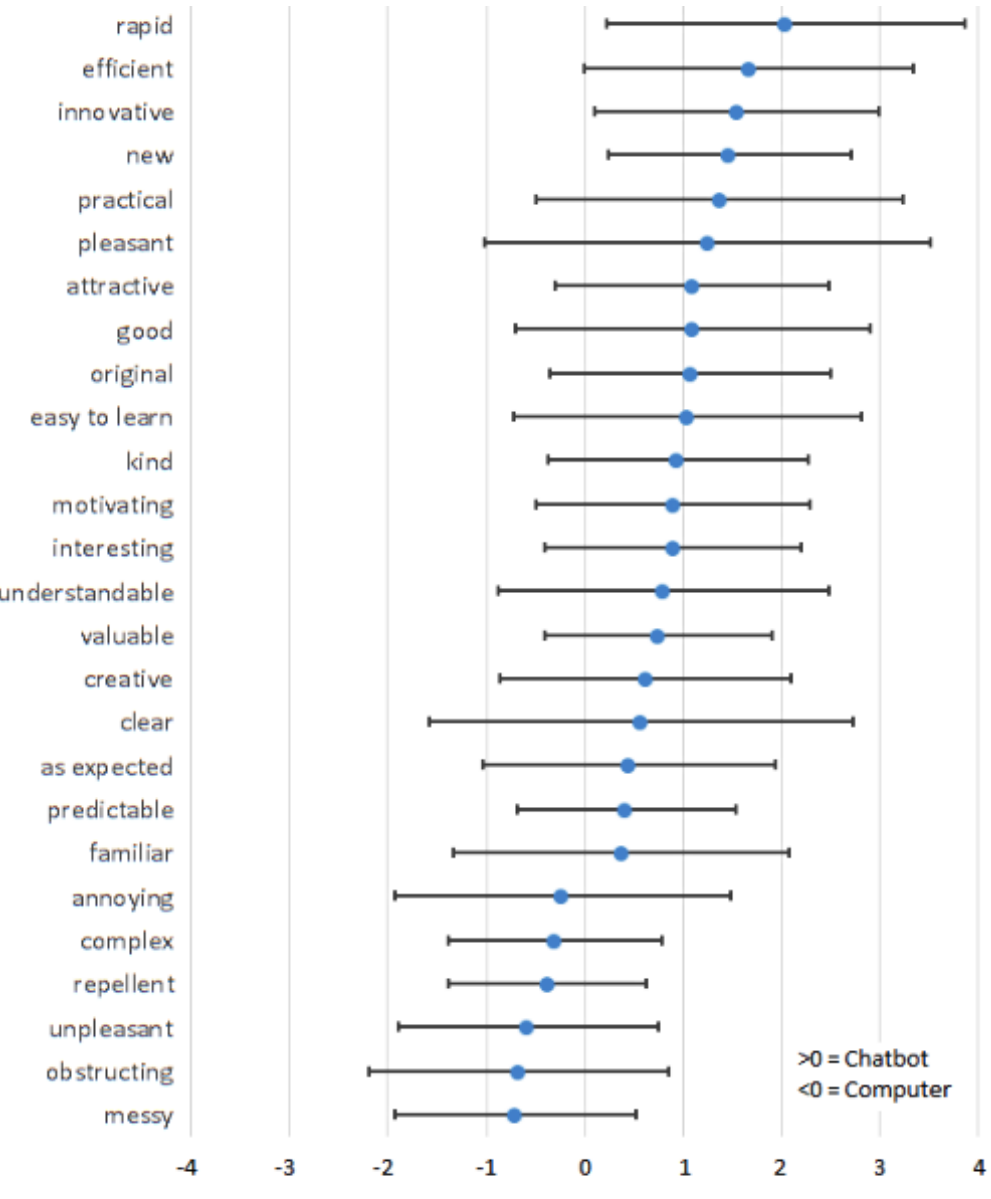
Figure 4. Average User Experience Questionnaire (UEQ) scores per term and standard deviation. A score above 0 illustrates that the term fits best with the chatbot. A score below 0 illustrates that the term fits best with the